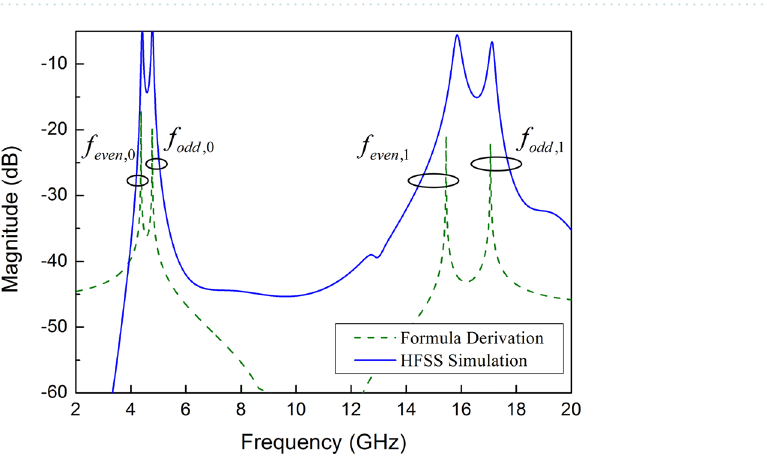
Figure 6. The resonance mode curves derived from the formula and HFSS simulation of SSLSIR loaded with slit